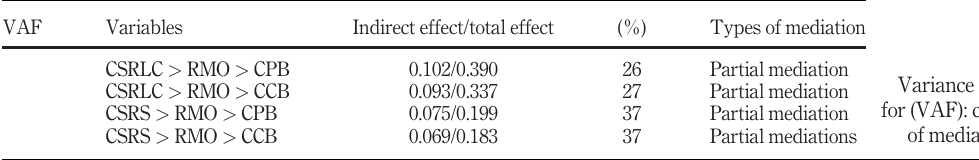
Table 6. Variance accounted for (VAF):